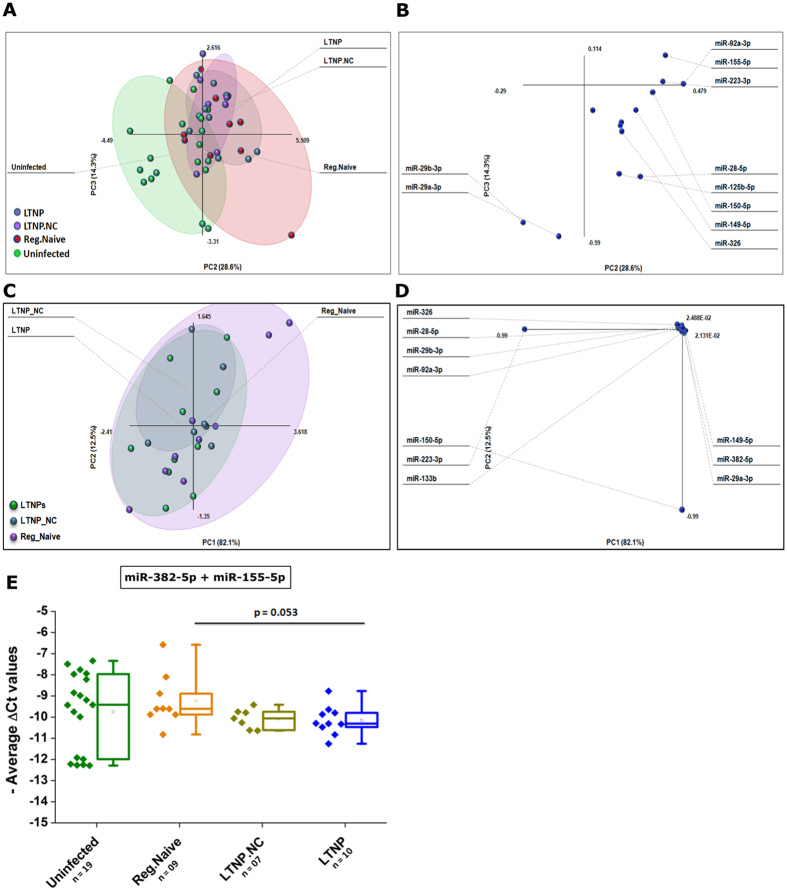
(A) Principle component analysis was done in Microsoft Excel by add-in “Multibase” package, using all 13 miRNA expression values (ΔCt) as variables. LTNPs and LTNP_NCs are clearly segregated from uninfected controls (A), while Regular_Naive individuals overlap partially on the 2D PCA plot (PC2 vs PC3). (B) The overall variance and 10 mostly contributing miRNAs in these two components. (C) PCA was done among 3 disease progressors classes. (D) The overall variance and 10 mostly contributing miRNAs in these two components. (E) LTNPs show substantially lower expression from Regular progressors, when average “−ΔCt” values of two miRNAs (miR-382-5p and miR-155-5p) were plotted.